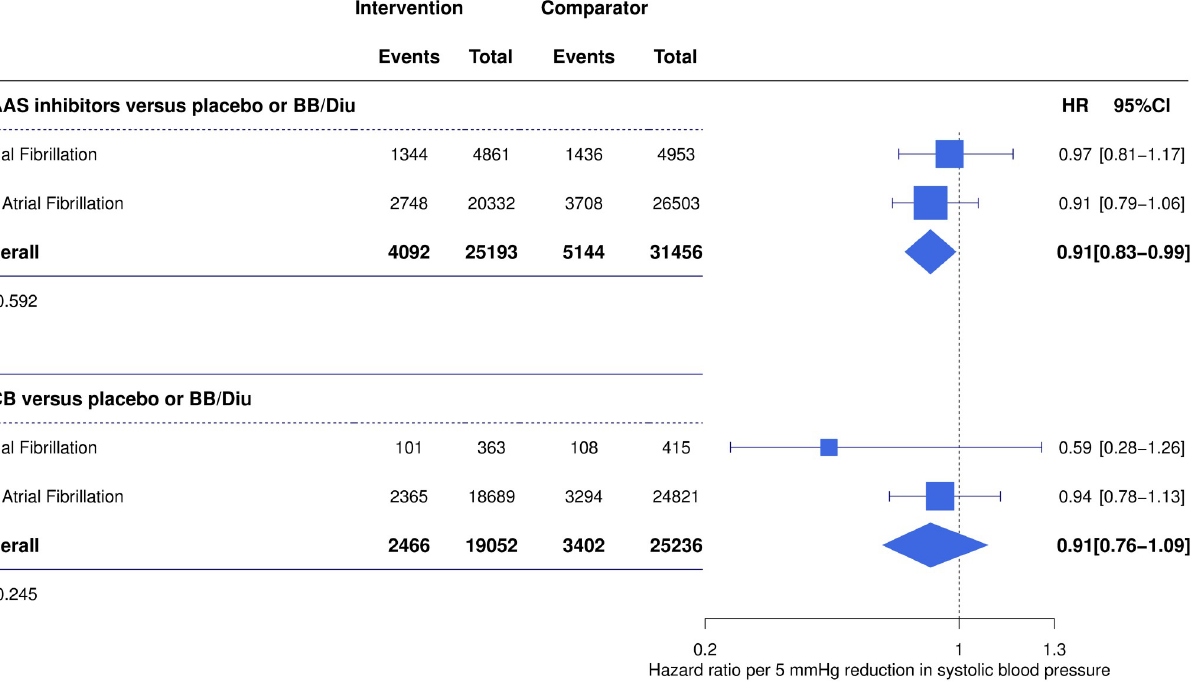
PLOS Medicine| https://doi.org/10.1371/journal.pmed.1003599 June 1,